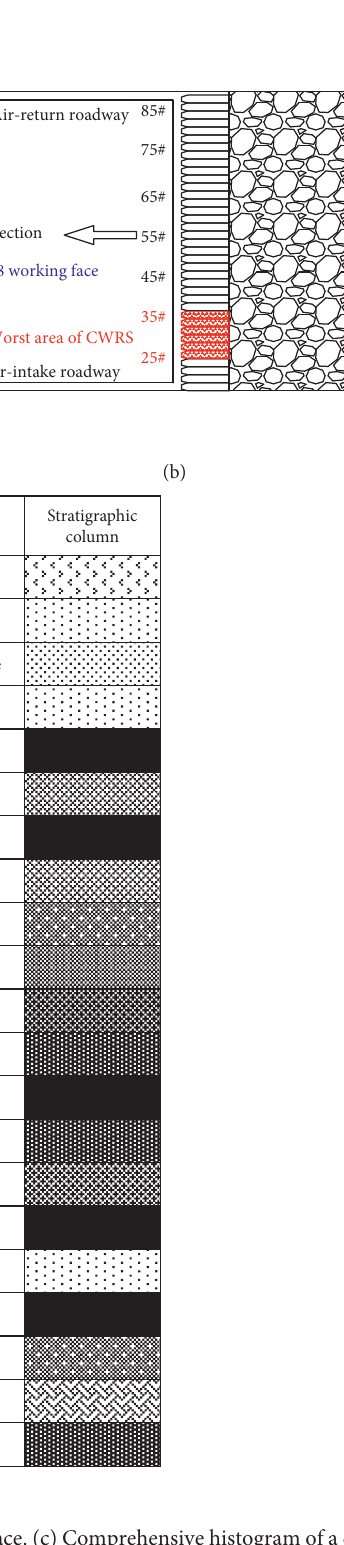
Figure 1:1508 Working Face profile. (a) Working face layout. (b) 1508 Working Face. (c) Comprehensive histogram of a coal seam in 1508 Working